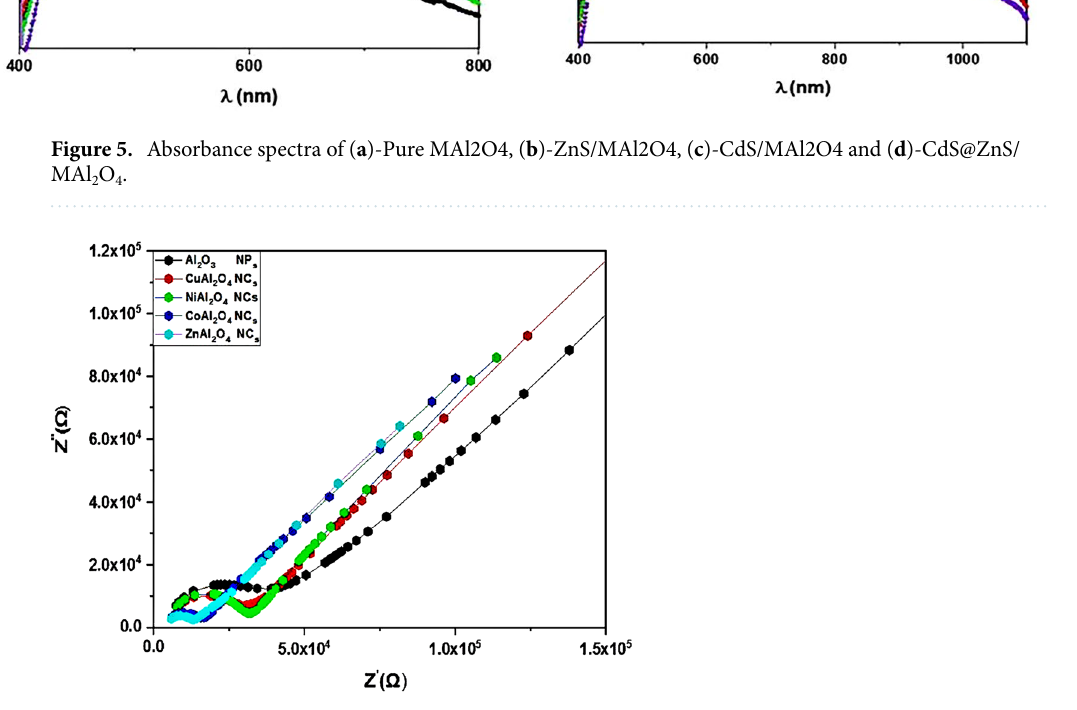
Figure 6. Nyquist plot of EIS spectra of CdS QDs deposited on Al2O3 NPs and MAl 2 O 4 (M=Cu, Co, Ni, and Zn) nanocomposites as WEs on